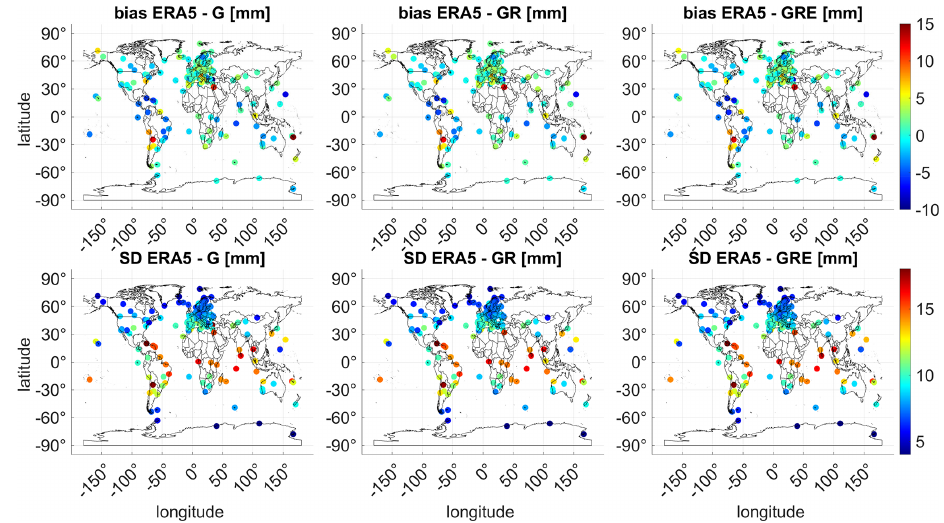
Figure 7. The map of ZTD biases and SDs for each station between the ERA5 model and three different GNSS solutions. The statistics are calculated for the year 2020.